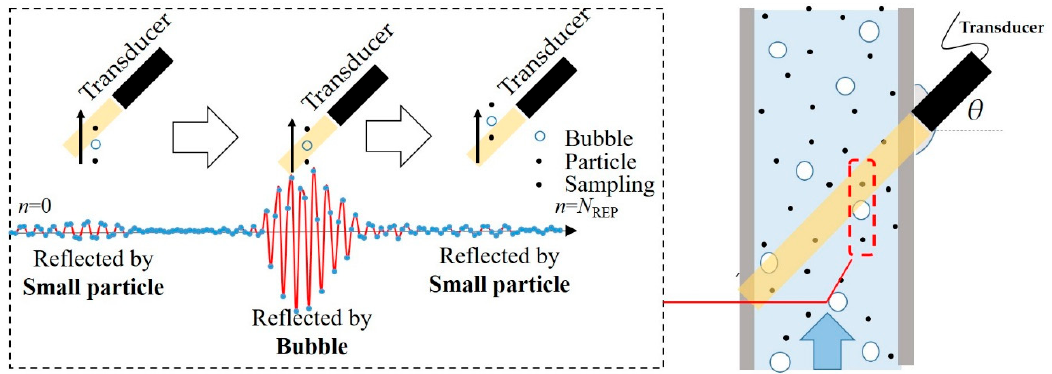
Figure 4. Multi ‐ frequency and different amplitude effects of the Doppler signal in one measurement channel in accordance with N REP .